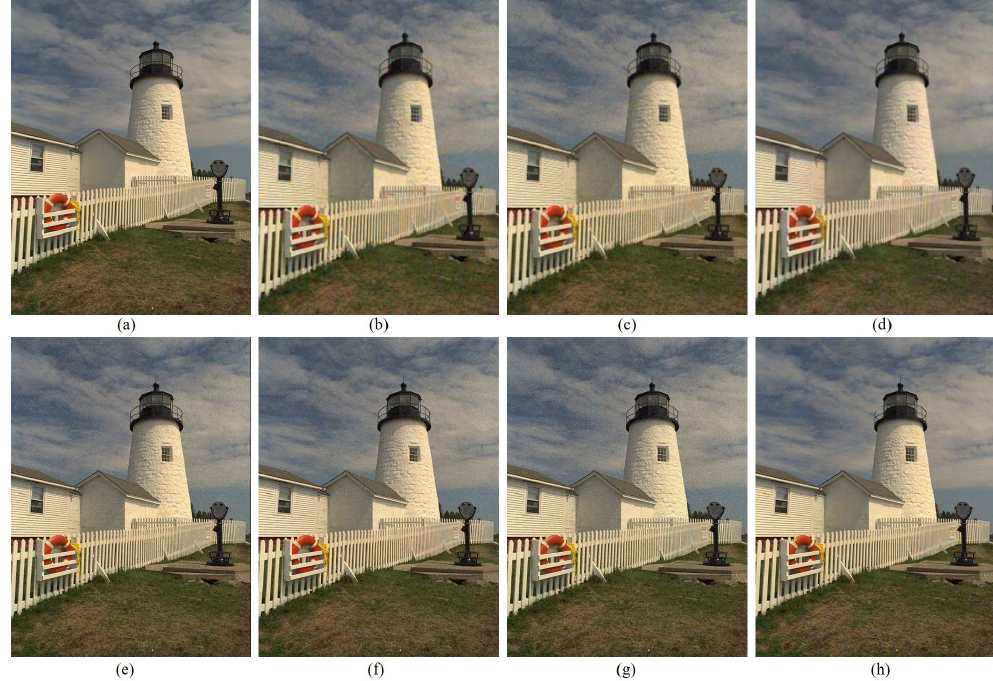
Figure 8. Visual comparison of the details between the results of different demosaicing methods on the Kodak No. 19 image: ( a ) original ( b ) RI [6] ( c ) Sony [15] ( d ) Paul’s [14] ( e ) DNet [19] ( f ) SEM [18] ( g ) LCNN [20] ( h )